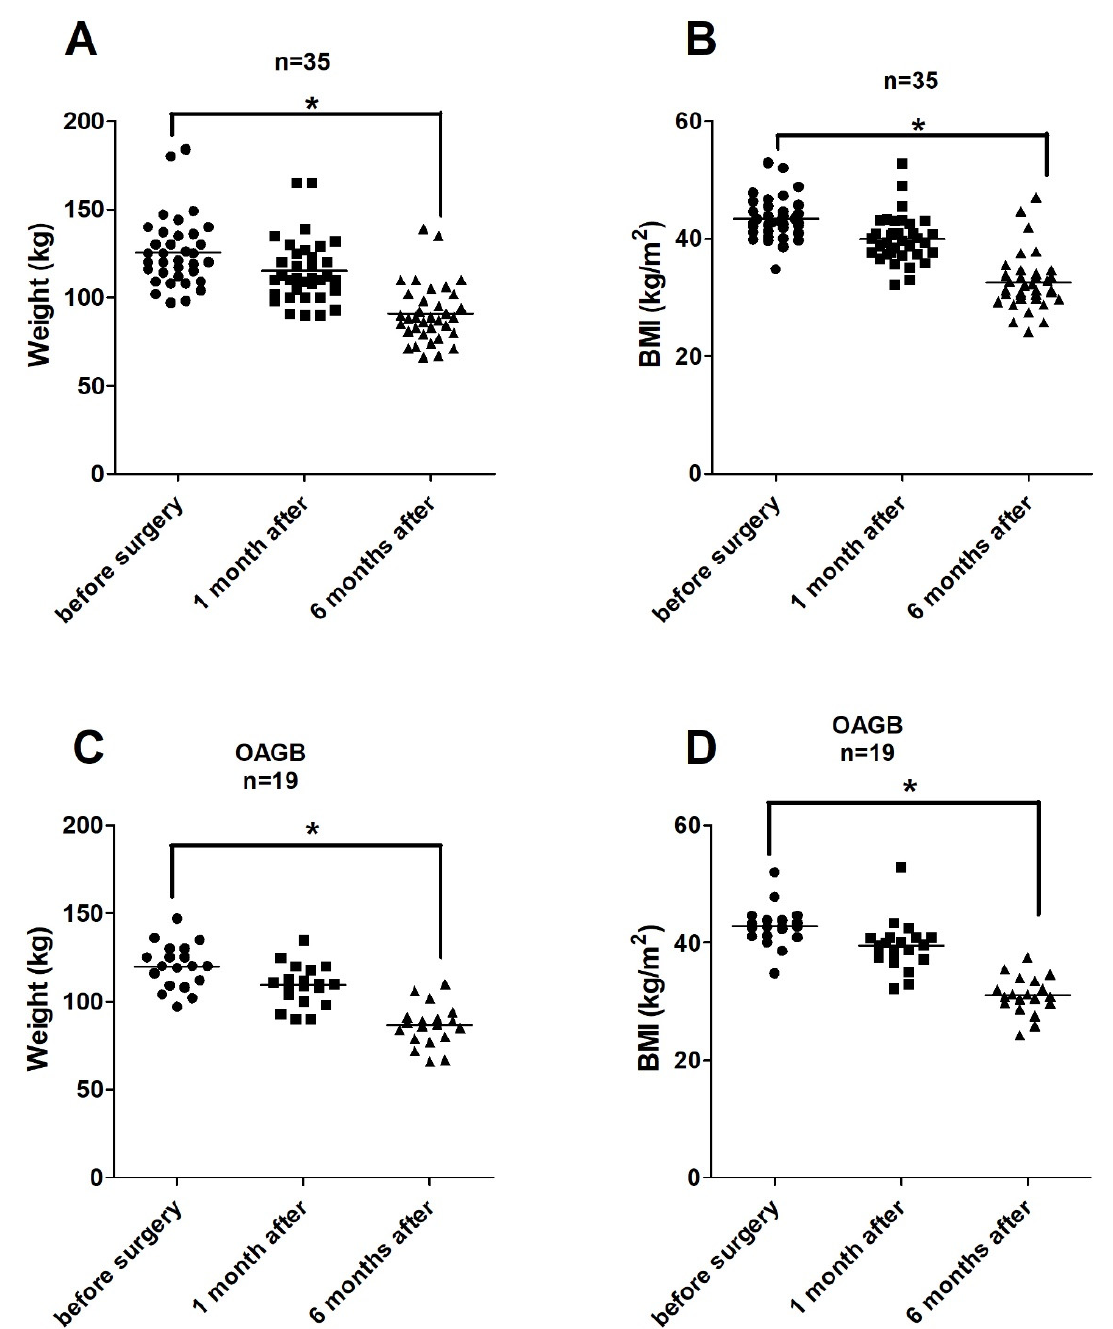
Figure 2. ( A – D ). Alterations of the body weights and of the BMI values after BS in all patients (2 A , 2 B , n = 35) and in the OAGB group (2 C , 2 D , n = 19). Points indicate individual data. Asterisks indicate statistical signi fi cance (* p ≤ 0.05).